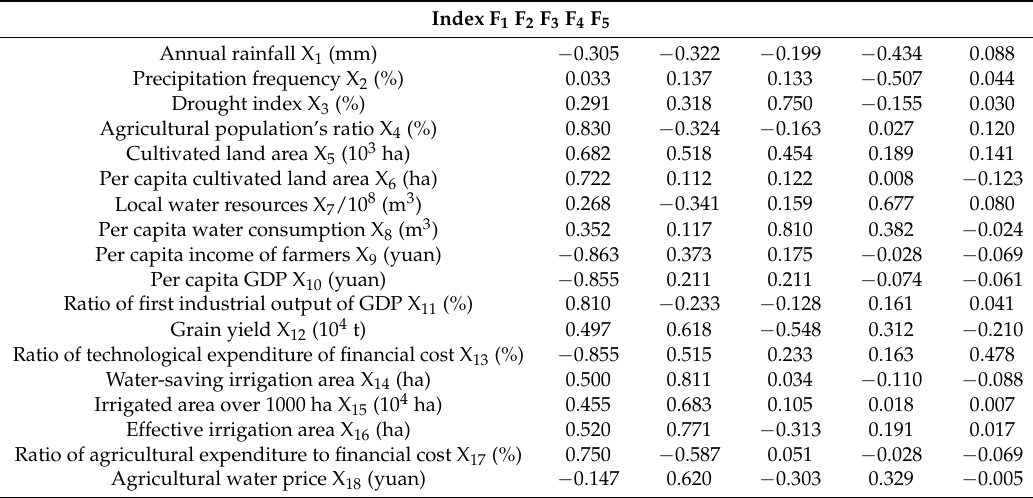
Table 2. Loadings of the first five principal factors on each variable.